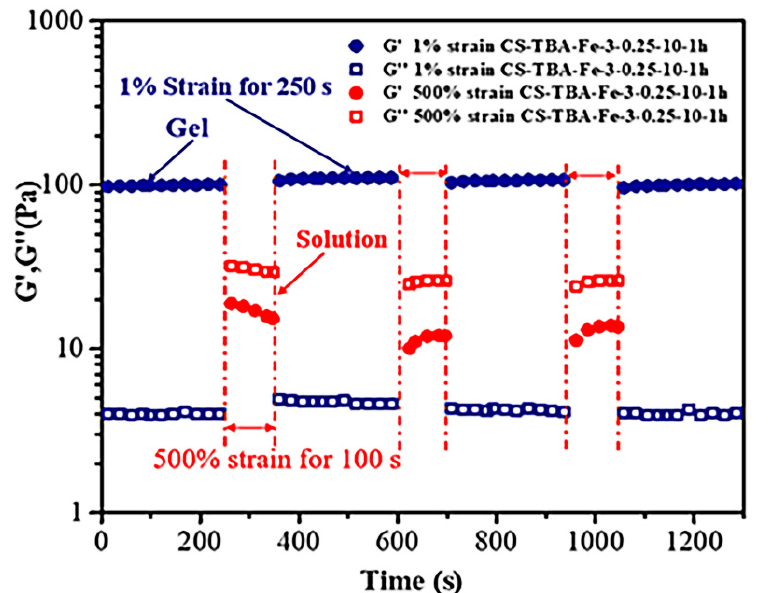
Figure 6. Self-healing ability of CS-TBA-Fe hydrogels under variable external strain (1% and 500%).